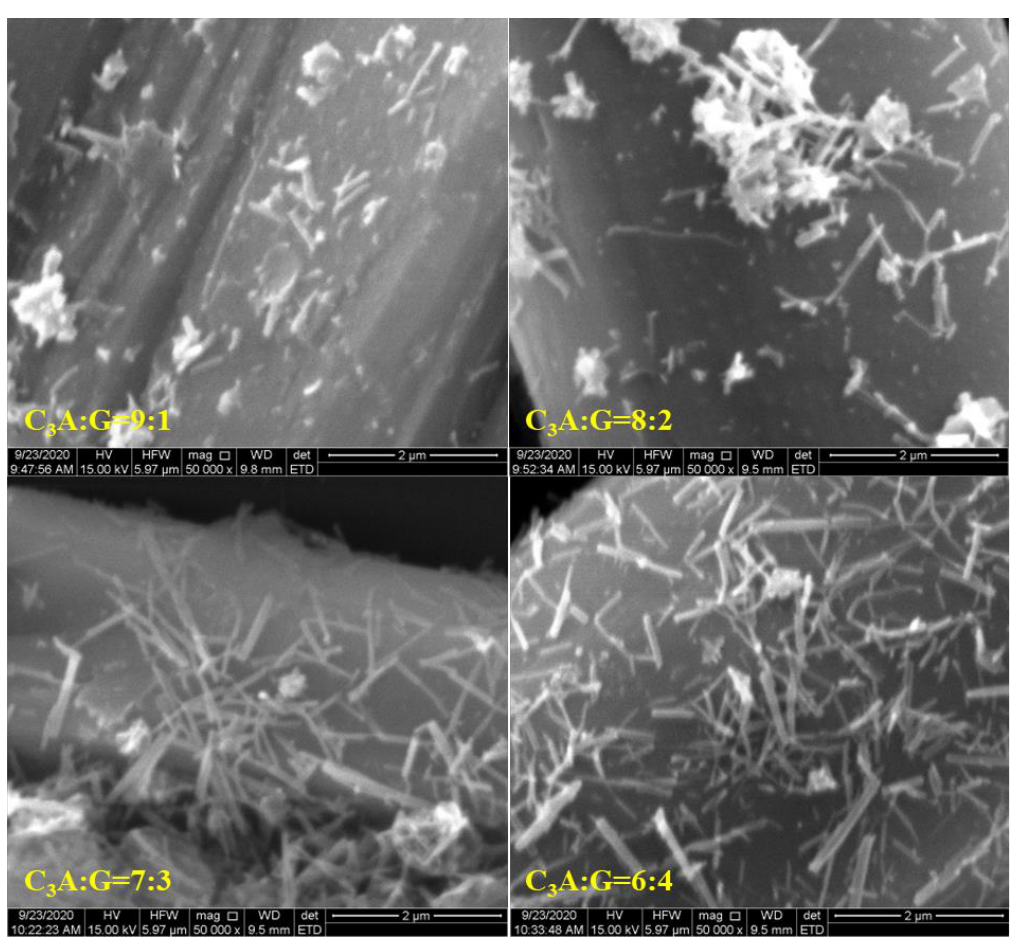
Figure 6. Effect of the proportion of gypsum in the C 3 A-gypsum system on morphology of precipitated ettringite.